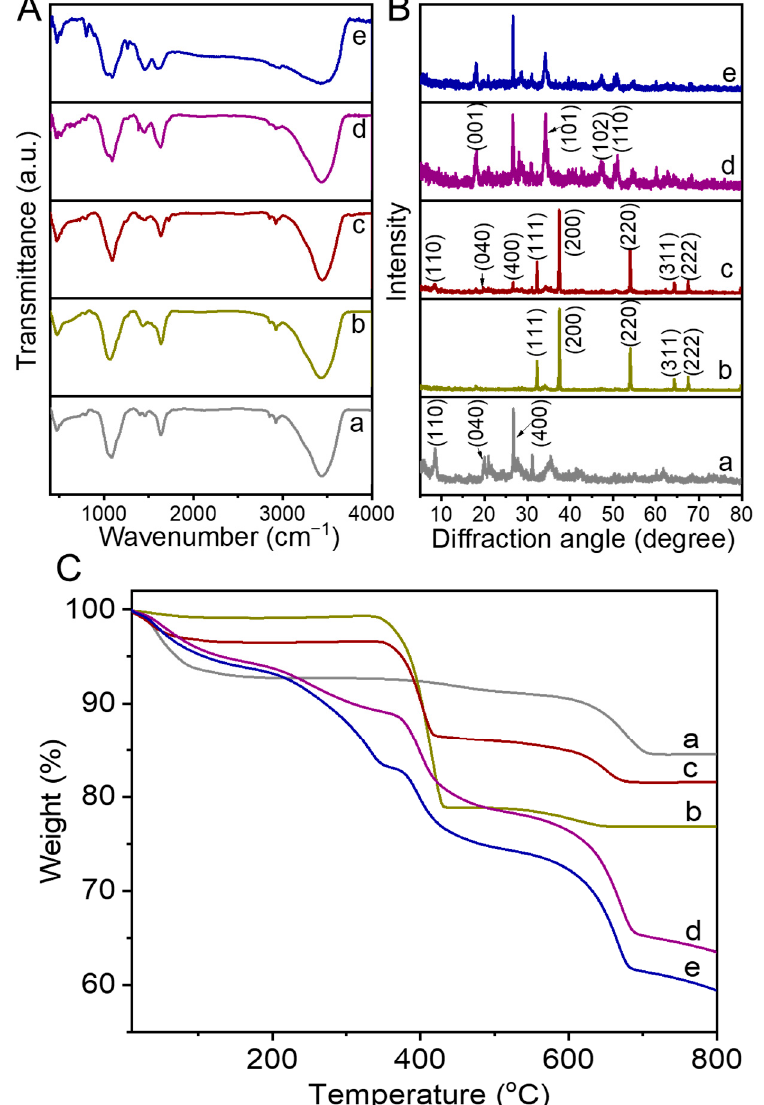
Figure 6. ( A ) FTIR spectra, ( B ) XRD patterns, and ( C ) TGA curves of (a) ATP, (b) CaO, (c) OATP/CaO, (d) OACT, and (e) OACT@ASO.